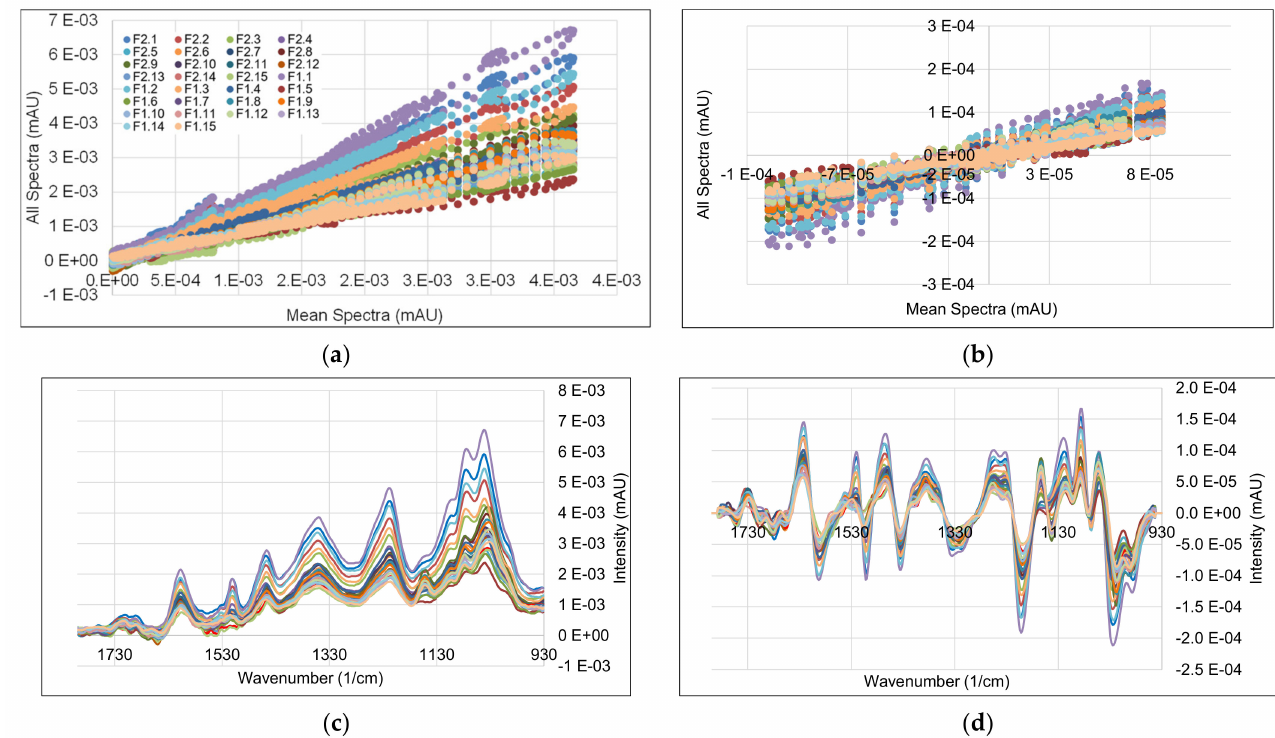
Figure 6. ( a ) Scatter effects of FTIR spectra before and ( b ) after preprocessing; ( c ) data of FTIR spectra before and ( d ) after preprocessing, legend from ( a ) applies for all